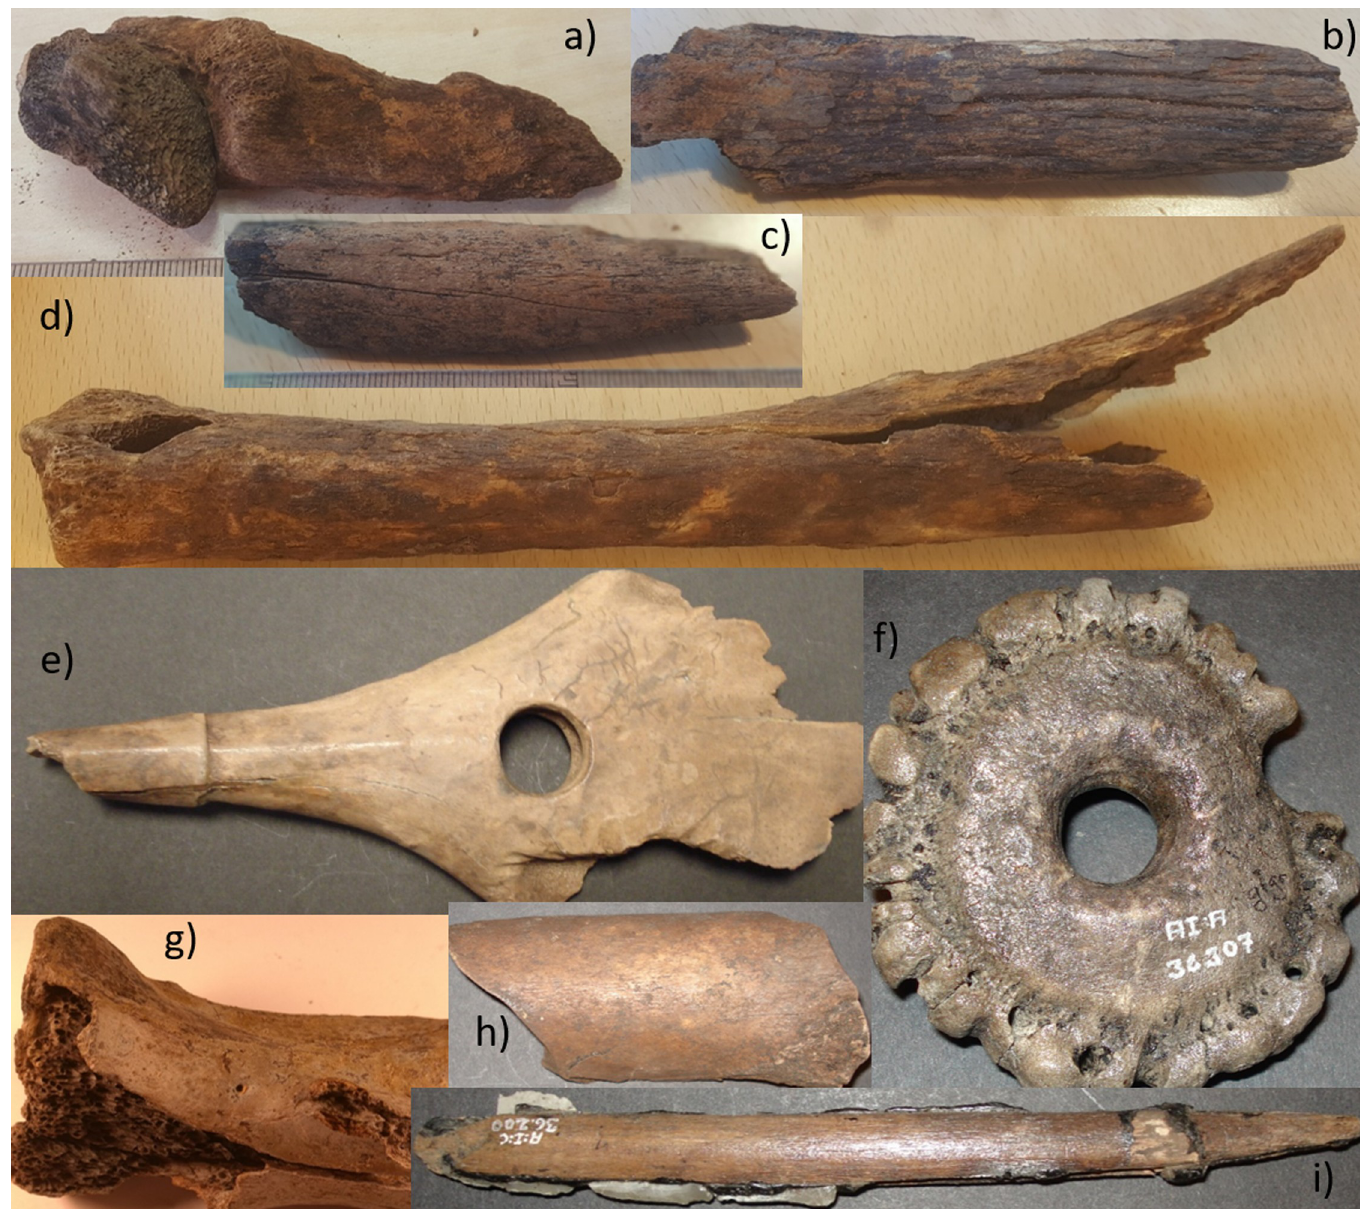
Fig 9. Organic bone preservation at Agero¨d. a-d bones from 2019; e-i from old excavations. a) astragalus and calcaneus from wild boar found articulated in the transition between white cultural layer and lower peat in trench 205, likely deposited in wet conditions with tendons and ligament still connected, weathering category 8. b) metatarsal from aurochs found in white cultural layer in trench 217, weathering category 6. c) radius diaphysis from elk found in white cultural layer in trench 201, one of the best-preserved bone fragments from the 2019 excavation, weathering category 3. d) tibia from red deer found in white cultural layer of trench 205, weathering category 7. e) drilled and ornated cervid antler from the 1940s, weathering category3. f) “net sinker” made from burr of red deer antler, from the 1940s excavation, weathering category 2. g) scapula from red deer found in the white layer in the 1970s, weathering category 3. h) femur diaphysis from aurochs from the 1940s, weathering category